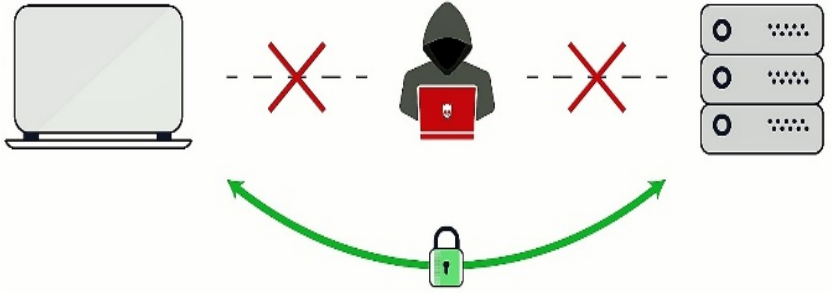
Figure 7. Man-in-the-middle attack in MAC layer.